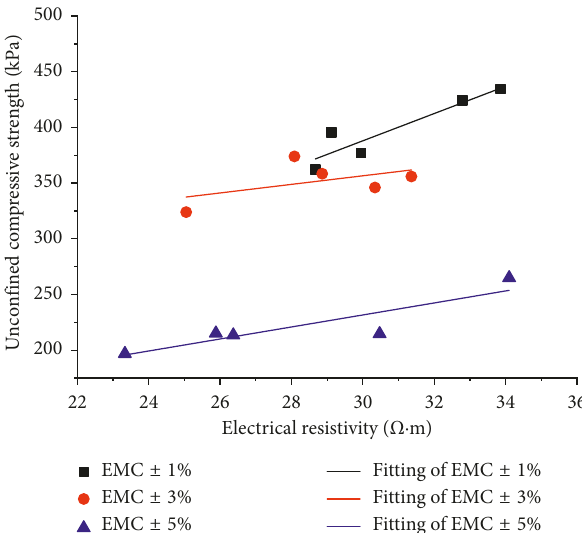
Figure 18: Relationship between electrical resistivity and un- confined compressive